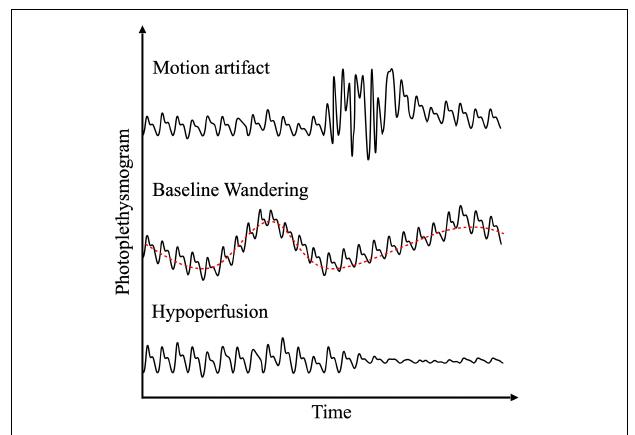
FIGURE 6 | Examples of representative PPG distortion due to motion artifact, baseline wandering, and hypoperfusion (from top to bottom).